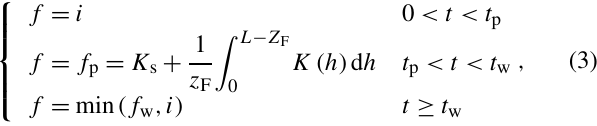
Initial water content distribution